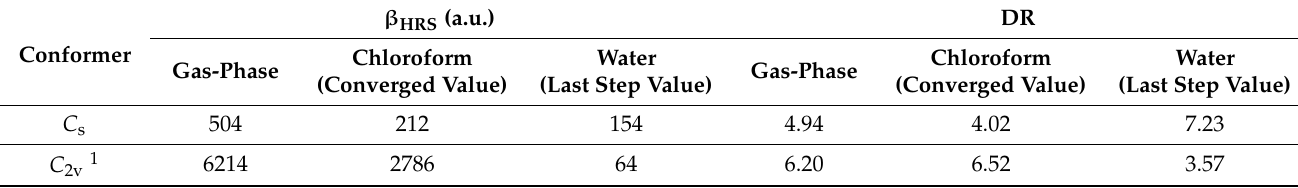
Table 3. MP2/aug-cc-pVDZ results for the static HRS first hyperpolarizability (in a.u.) and depolar- ization ratio of the C s conformer. For comparison, the corresponding results for the C 2v conformer are